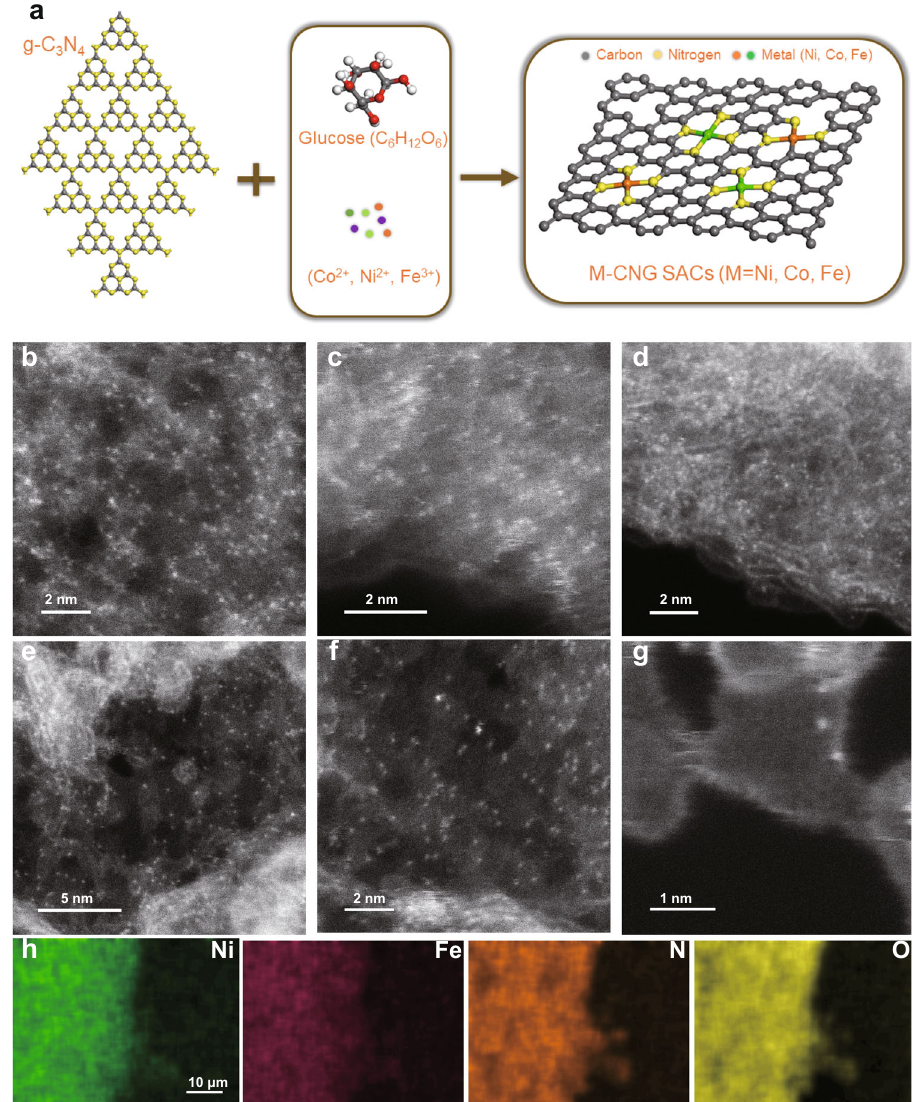
Fig. 1 Fabrication route and morphological characterization. a Scheme of molecular tailoring synthesis of graphene-based SACs using g-C 3 N 4 and glucose as precursors. b – d HAADF-STEM images of b Ni-CNG, c Co-CNG, and d Fe-CNG. e – g HAADF-STEM images of NiFe-CNG at different magni fi cations. The uniformly distributed bright dots represent metal atoms. h EDS mapping of NiFe-CNG recorded along with the